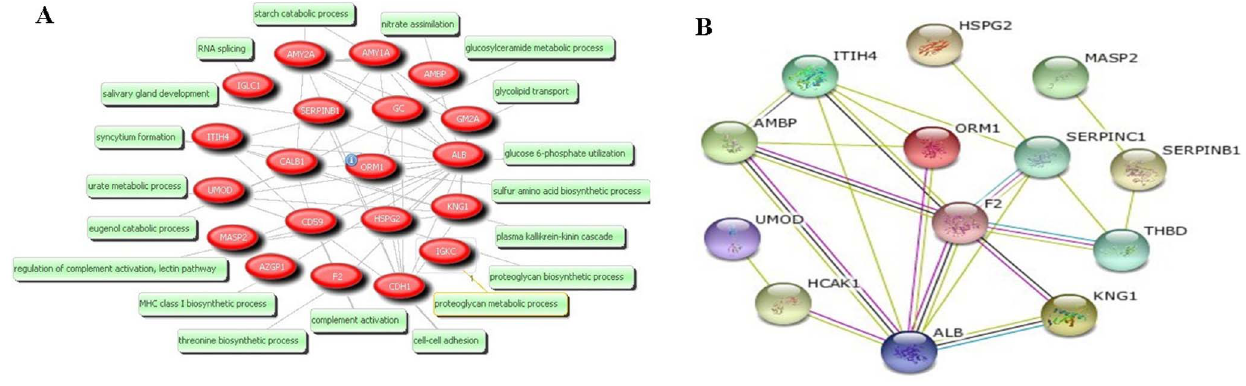
Figure 2. Bioinformatic analysis of bio-association network by Pubgene and String programs. (A) Bio-process associated with the twenty identified proteins was indicated by Pubgene. (B)The ORM1 protein function partner network was indicated by String analysis.